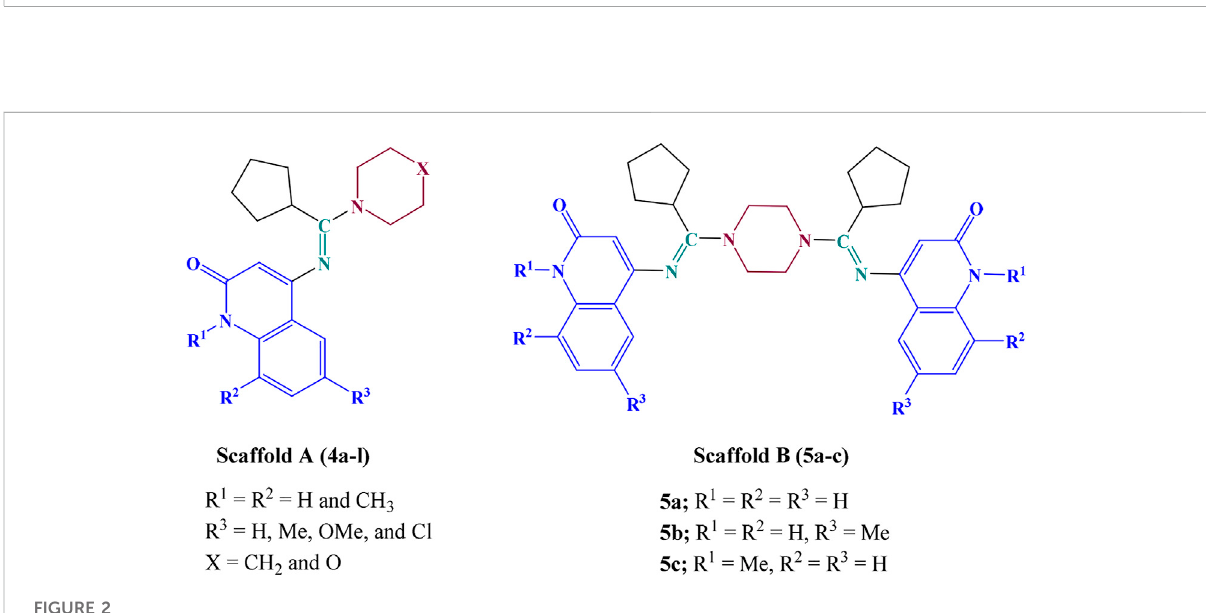
FIGURE 2 Structures of new quinoline-based derivatives 4a-l and